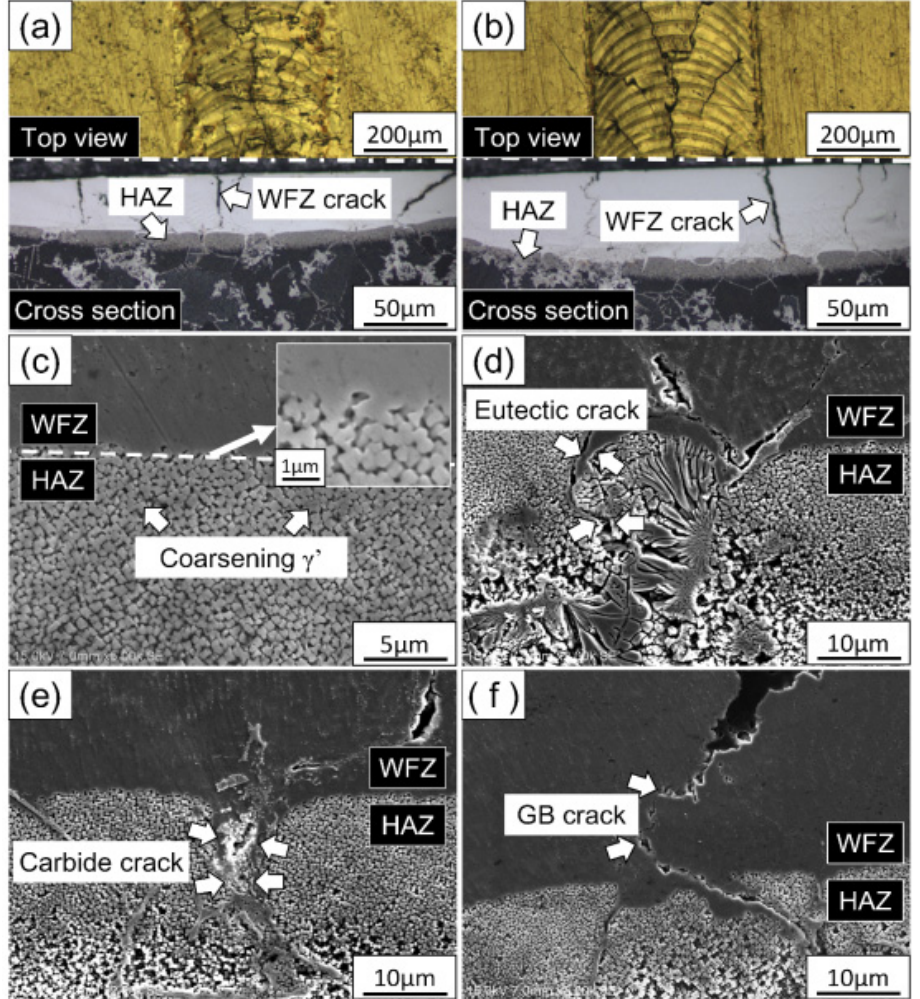
Figure 2. Crack observation on the surface and cross ‐ section of ( a ) Condition B, ( b ) Condition C, and ( c ) HAZ observation of Condition B. Various liquidation cracks, including ( d ) eutectic, ( e ) carbide, and ( f ) grain boundary cracks, are observed in HAZ of Condition B.